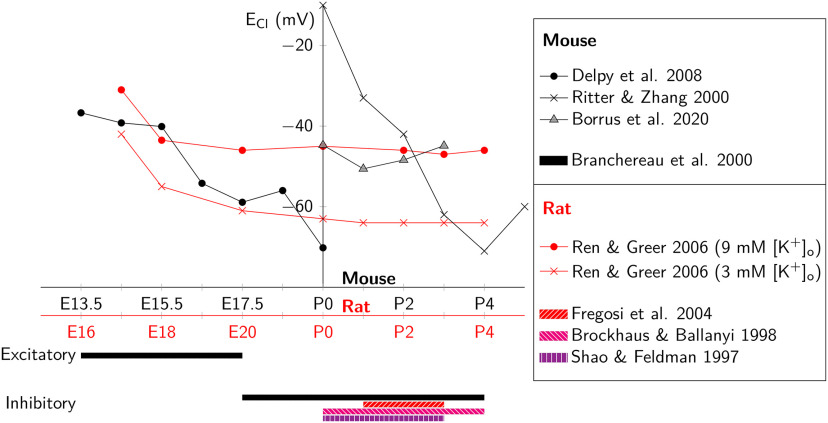
Meta-analysis of ECl during development in hindbrain and spinal cord of mice and rats. Red reflects rat data, black reflects mouse. The abscissa shows age (in days) centered at birth (P0). The ordinate shows ECl (in mV) as a function of age. Below the x-axis, we show binary classification of ECl as either above (excitatory) or below (inhibitory) baseline membrane potential as a function of developmental age. Our present data are labeled Borrus et al. (2020). We obtained ECl data from perinatal mice from: Branchereau et al. (2000), Delpy et al., 2008, Ritter and Zhang (2000), and data from the present manuscript, i.e., Borrus et al. (2020). We obtained ECl data from perinatal rats from: Brockhaus and Ballanyi (1998), Fregosi et al. (2004), Ren and Greer, 2006, as well as Shao and Feldman (1997).